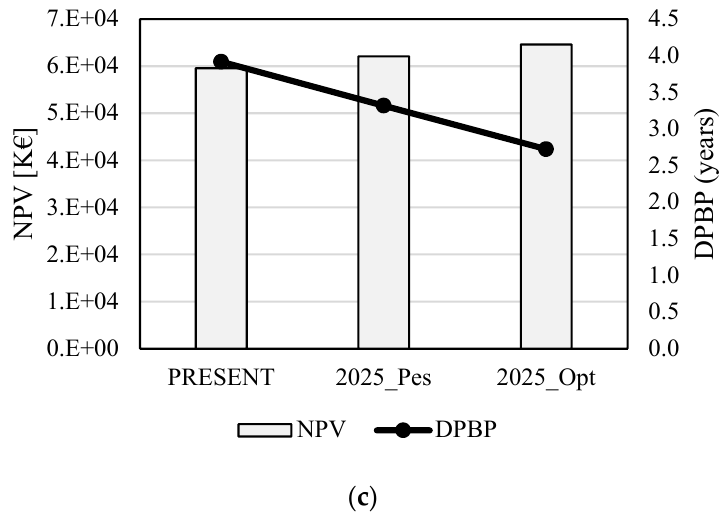
Figure 10. NPV and discounted payback period (DPBP) variations between the present and 2025 in optimistic and pessimistic scenarios for CPV systems adopted for the three users: ( a ) house; ( b ) hotel; and ( c ) industry.